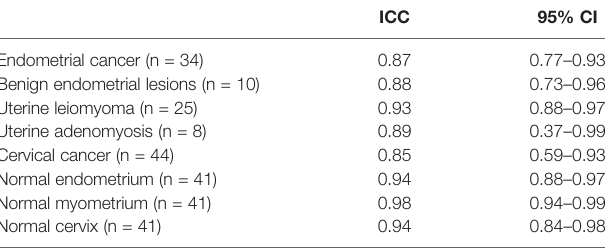
TABLE 3 | Interobserver agreement for the measurement of MTR